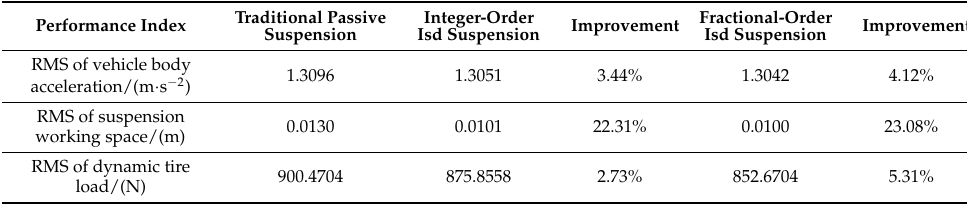
Figure 10. Comparison of the dynamic tire load. Table 4. Comparison of performance indexes of three